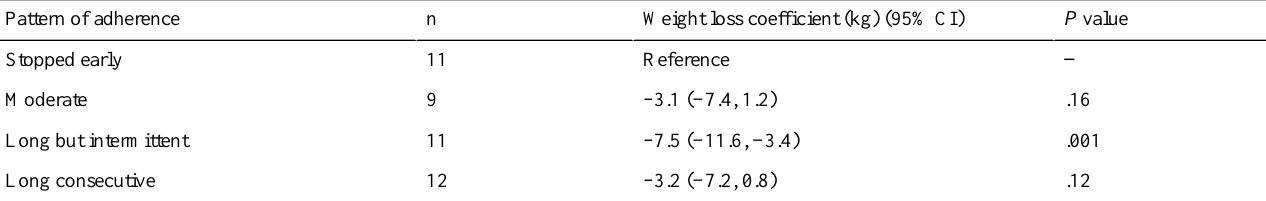
Table 5. Regression analysis of pattern of My Meal Mate use as a predictor of follow-up weight (adjusted for baseline weight) in the My Meal Mate arm of the pilot trial.